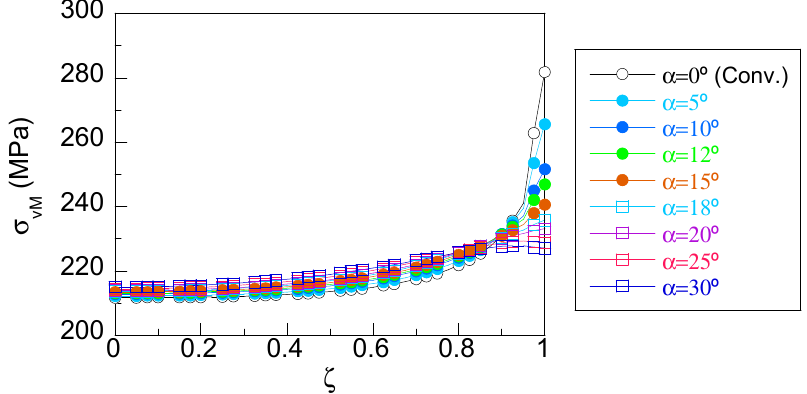
Figure 9. Hub axial distribution of von Mises stress at the shaft–hub interface. As in the previous distributions, the effect of the chamfer vanished as the distance from the hub edge increased, reaching similar values to the ones predicted by theory for